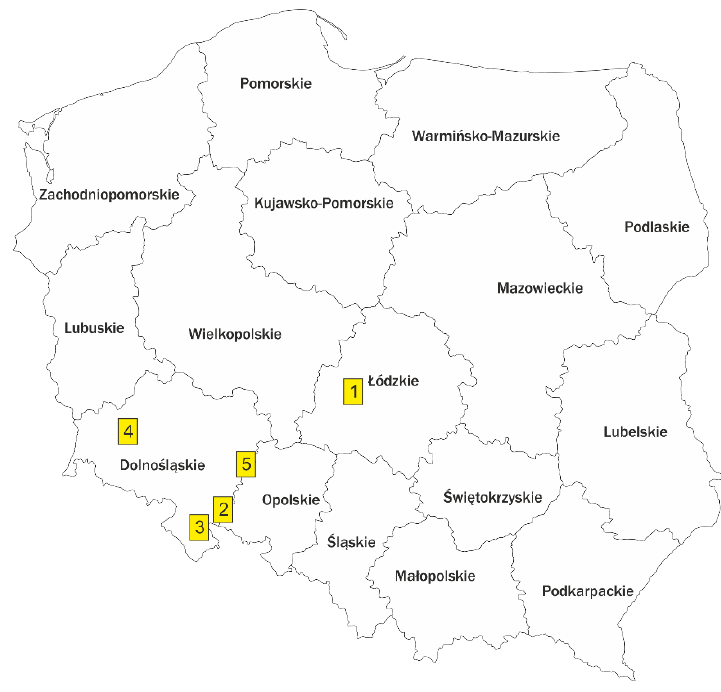
Figure 3. Location of wind turbines under study.